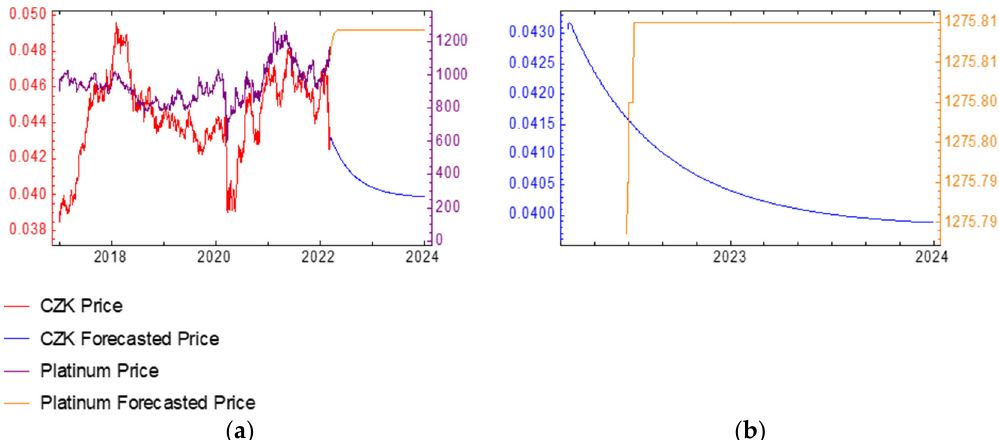
Figure 12. Past development of platinum and CZK prices and their prediction until the end of 2023 ( a ) past development of platinum and CZK prices with their future development to the end of 2023, ( b ) cutout of the future development of platinum and CZK prices.